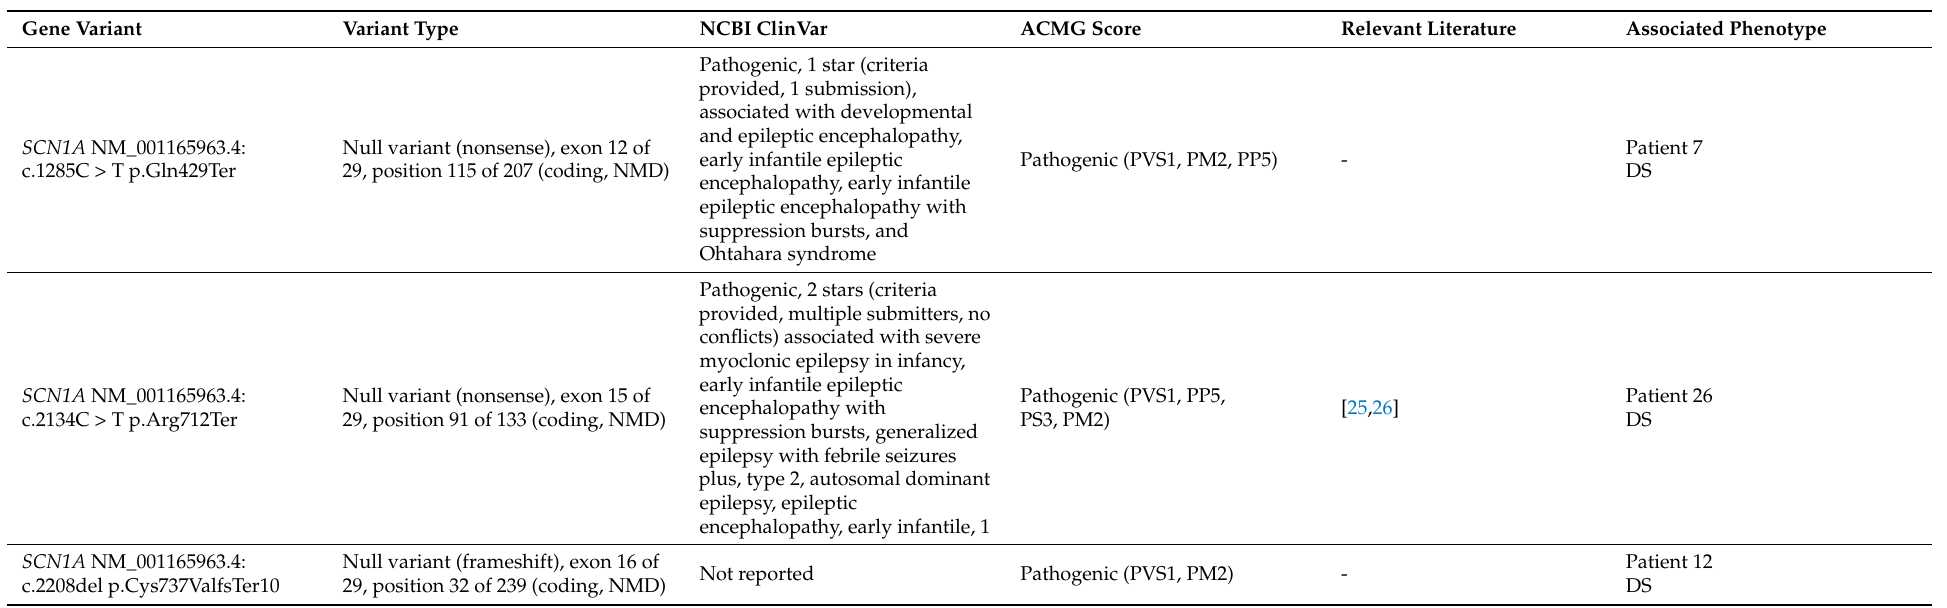
Table 2. Identified variants—MANE transcript, HGVS nomenclature, variant type, ClinVar information, ACMG score, and relevant literature on the variant. We are showing our patients the matching diagnosis given the clinical